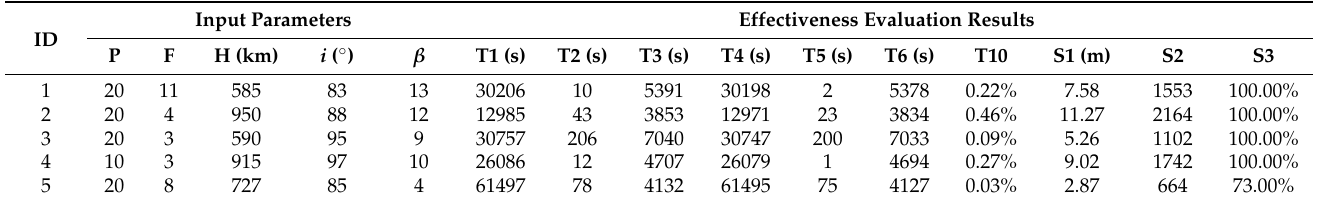
Table 2. The input parameters and effectiveness evaluation results of the first 5